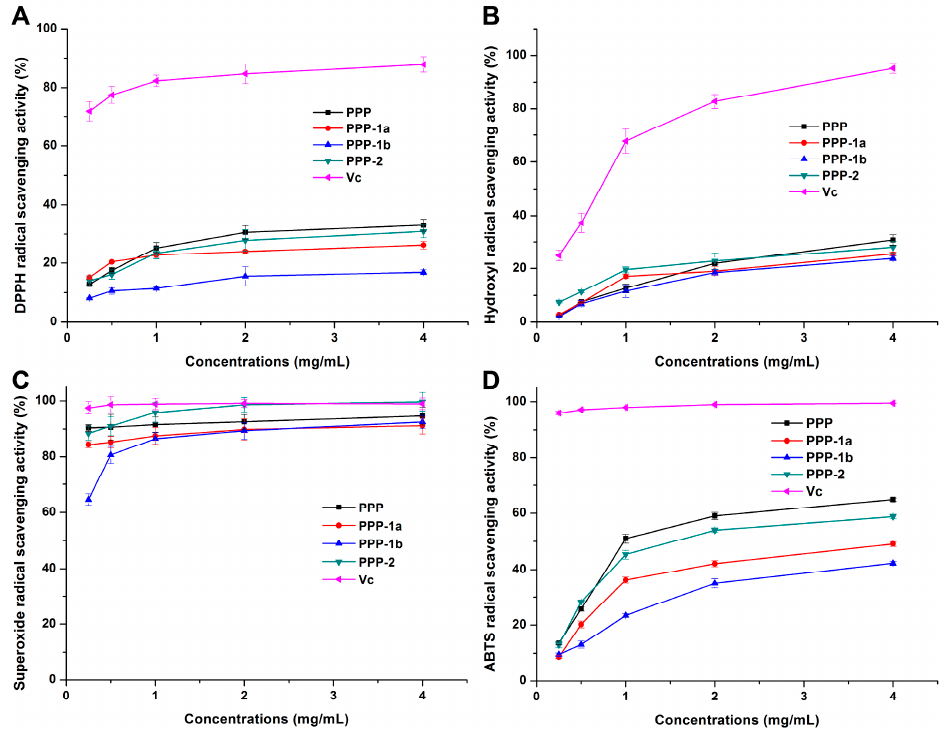
Figure 5. Scavenging effects of PPP, PPP-1a, PPP-1b and PPP-2 on DPPH radical ( A ), hydroxyl radical ( B ), superoxide radical ( C ) and ABTS radical ( D ), respectively.